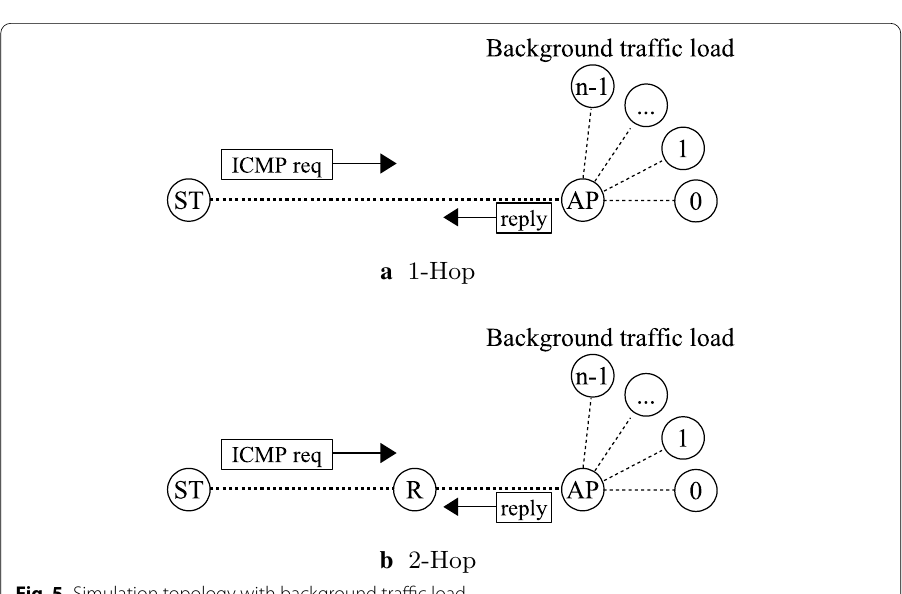
Fig. 5 Simulation topology with background traffic